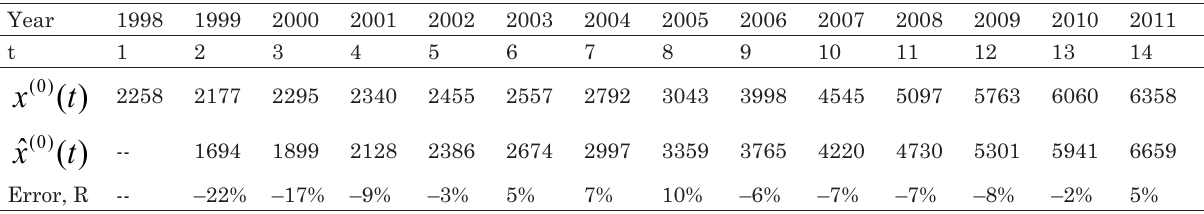
Table 2. The real and estimated values on affordable housing pricing based on GM